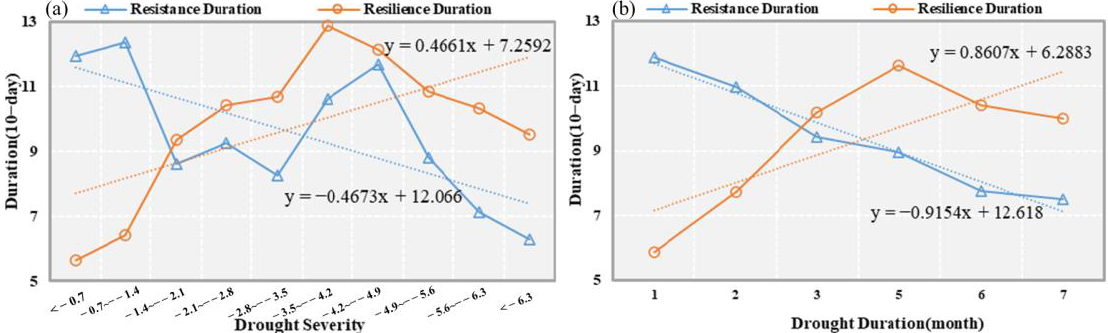
Figure 6 . The impacts of drought duration and drought severity on resistance duration and resili- ence duration. ( a ) impacts of drought severity in 2005/2006; ( b ) impacts of drought duration in